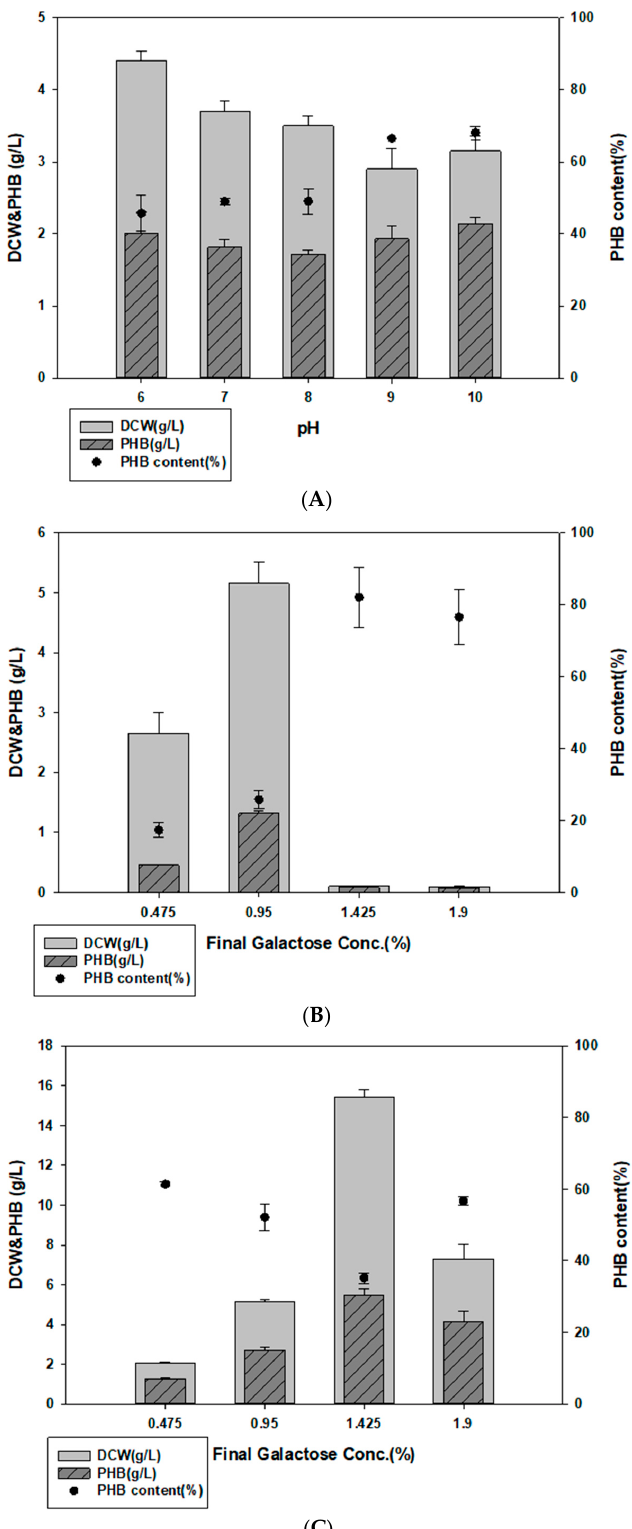
Figure 4 . PHB production with E. spinosum hydrolysate and optimal pH. ( A ) Effect of pH on PHB production in MB with 1% galactose in E. spinosum hydrolysate. ( B ) DCW and PHB production after culture with E. spinosum hydrolysate ( C ) DCW and PHB production after culture with E. spinosum hydrolysate and activated carbon.